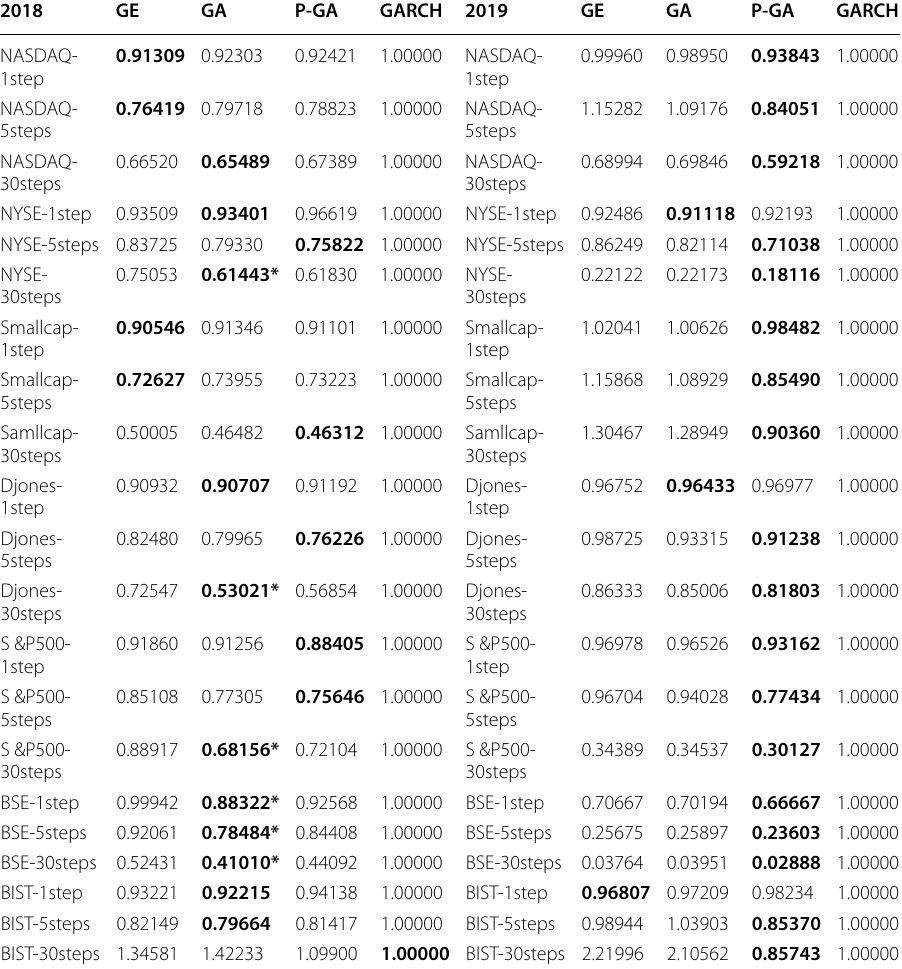
Column names “GA” and “GE” represent GE-NoVaS and GA-NoVaS methods, respectively; “GARCH” means the GARCH-direct method; and “P-GA” means the P-GA-NoVaS method. As the benchmark is the GARCH-direct method, numerical values in the table corresponding to the GARCH-direct method are 1. Other numerical values are relative performance compared to the GARCH-direct method. The bold value indicates that the corresponding method is the optimal choice for this data case. A cell with indicates that the GA-NoVaS method is at least 10 % better than the GE-NoVaS method, or inversely, the ∗ GE-NoVaS method is at least 10 %